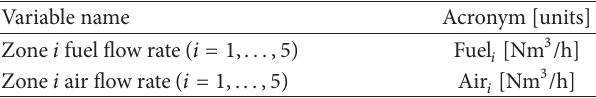
Table 1: The Manipulated Variables.